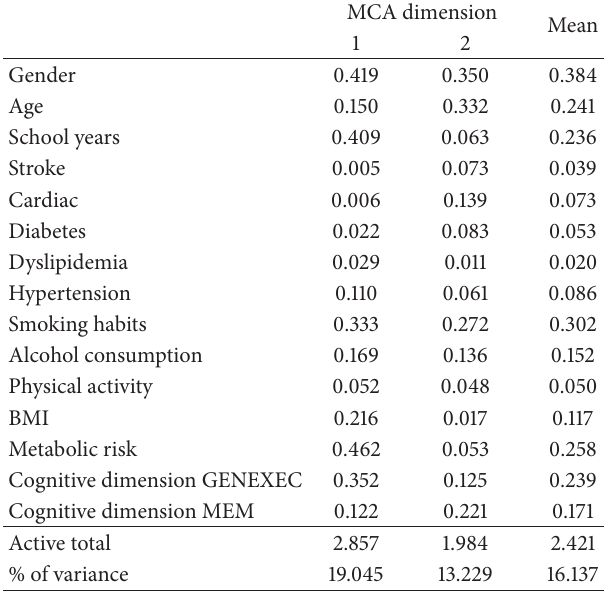
Table 2: MCA dimensions discrimination